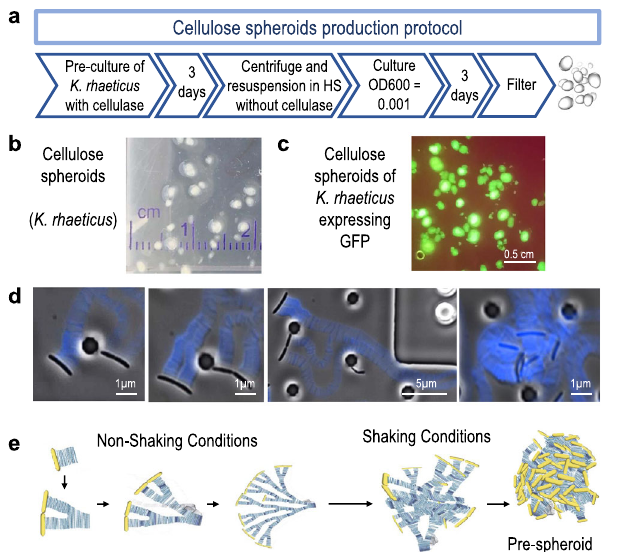
Fig. 1 Bacterial cellulose (BC) spheroid production. a Schematic of the protocol steps to produce BC spheroids from K. rhaeticus in shaking cultures. b Example image of BC spheroids produced by wild-type K. rhaeticus cells. c Example fl uorescence image of BC spheroids produced by superfolder GFP-expressing K. rhaeticus cells. d Microscopic images of a micro fl uidic growth time-lapse of K. rhaeticus cells growing at low density with calco fl uor blue staining of cellulose bands. Images show the fi rst stages of BC spheroid development. Images are representative of four experiments. e Schematic showing the growth progression of cellulose in static and shaking conditions, hypothesised to lead BC spheroid formation.